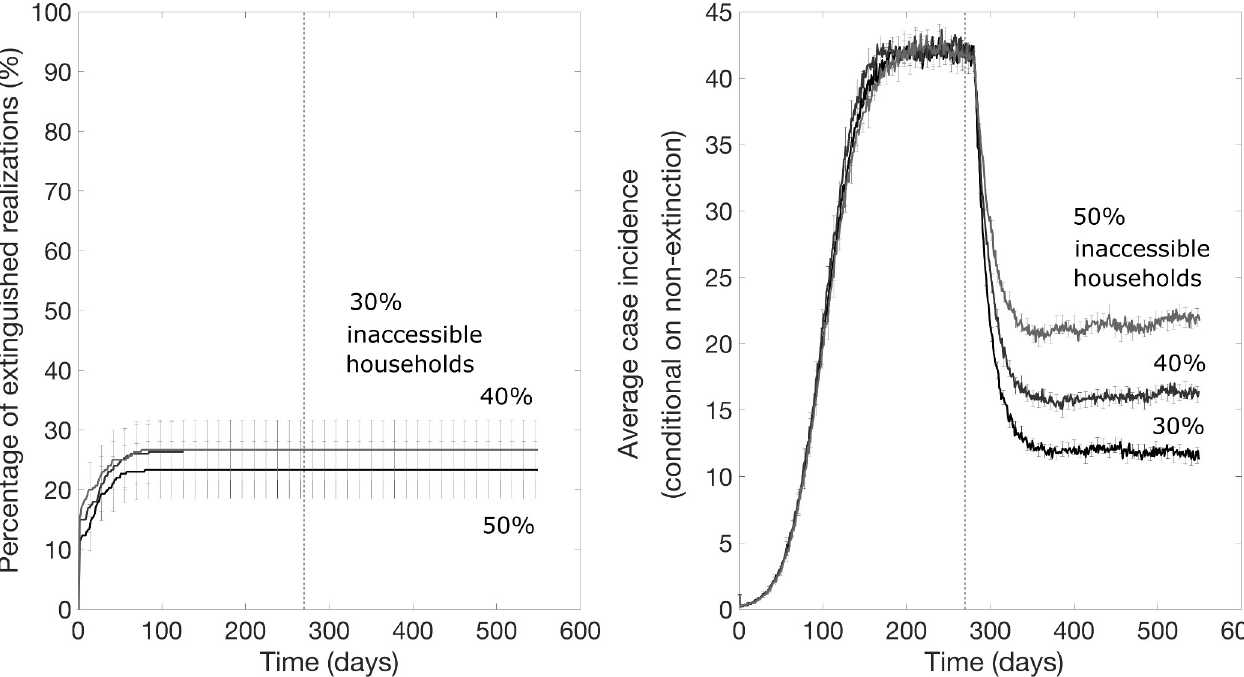
Fig 7. The impact of ring vaccination on an established epidemic wave (after a delay of 270 days) on the probability of outbreak extinction and the mean daily incidence curves for various percentage levels of household inaccessibility. These simulations were generated using the exponential transmission profile, but similar results were obtained using the gravity transmission profile described in the main text. The vertical dashed line indicates the timing of start of the ring vaccination program.